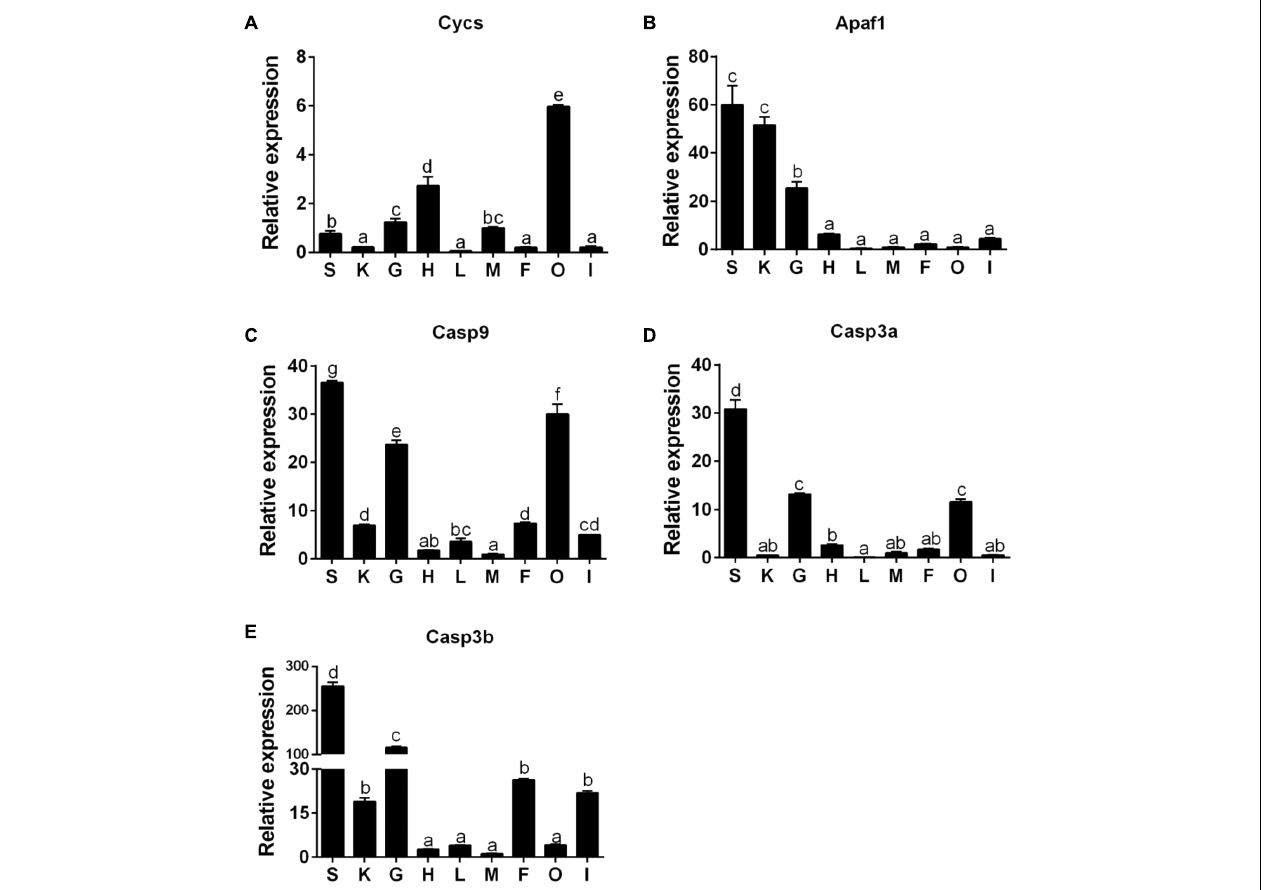
FIGURE 6 | The tissue-specific expression of five apoptosis related genes across spleen (S), kidney (K), gill (G), heart (H), liver (L), muscle (M), mesenteric fat (F), ovary (O), and intestine (I) of P. fulvidraco via quantitative PCR (Q-PCR) ( A: Cycs; B: Apaf1; C: Casp9; D: Casp3a; E: Casp3b). Data (mean ± SEM, n = 6) were expressed relative to expression of housekeeping gene (GAPDH and HPRT). Expression of genes in muscle was regarded as the relative expression 1. Bars with different letters indicate significant differences among nine tissues ( P <